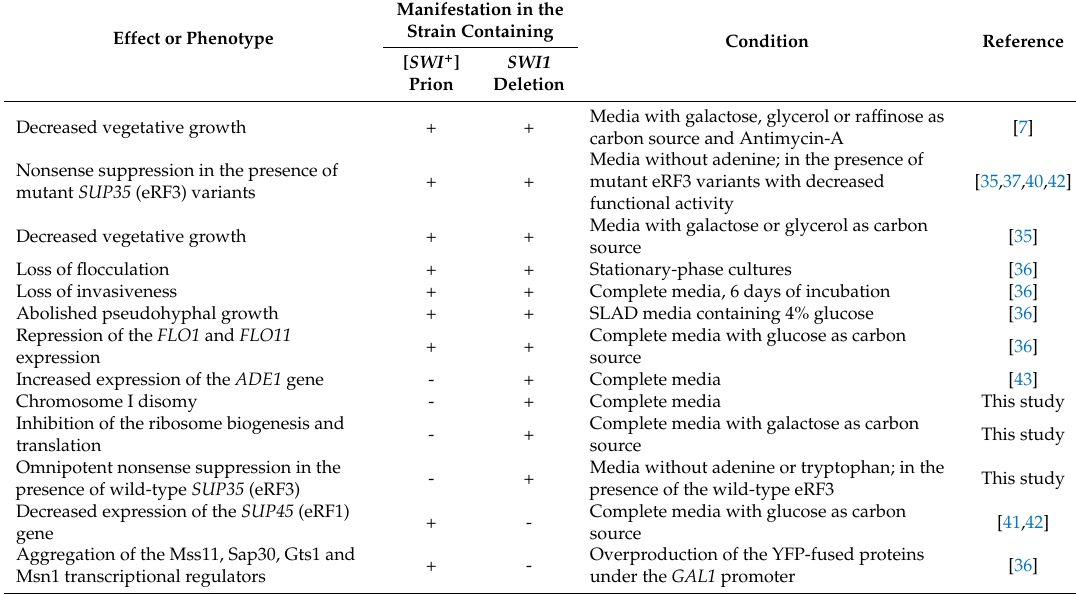
Table 2. Similarities and differences between the effects of the [ SWI + ] prion and the swi1